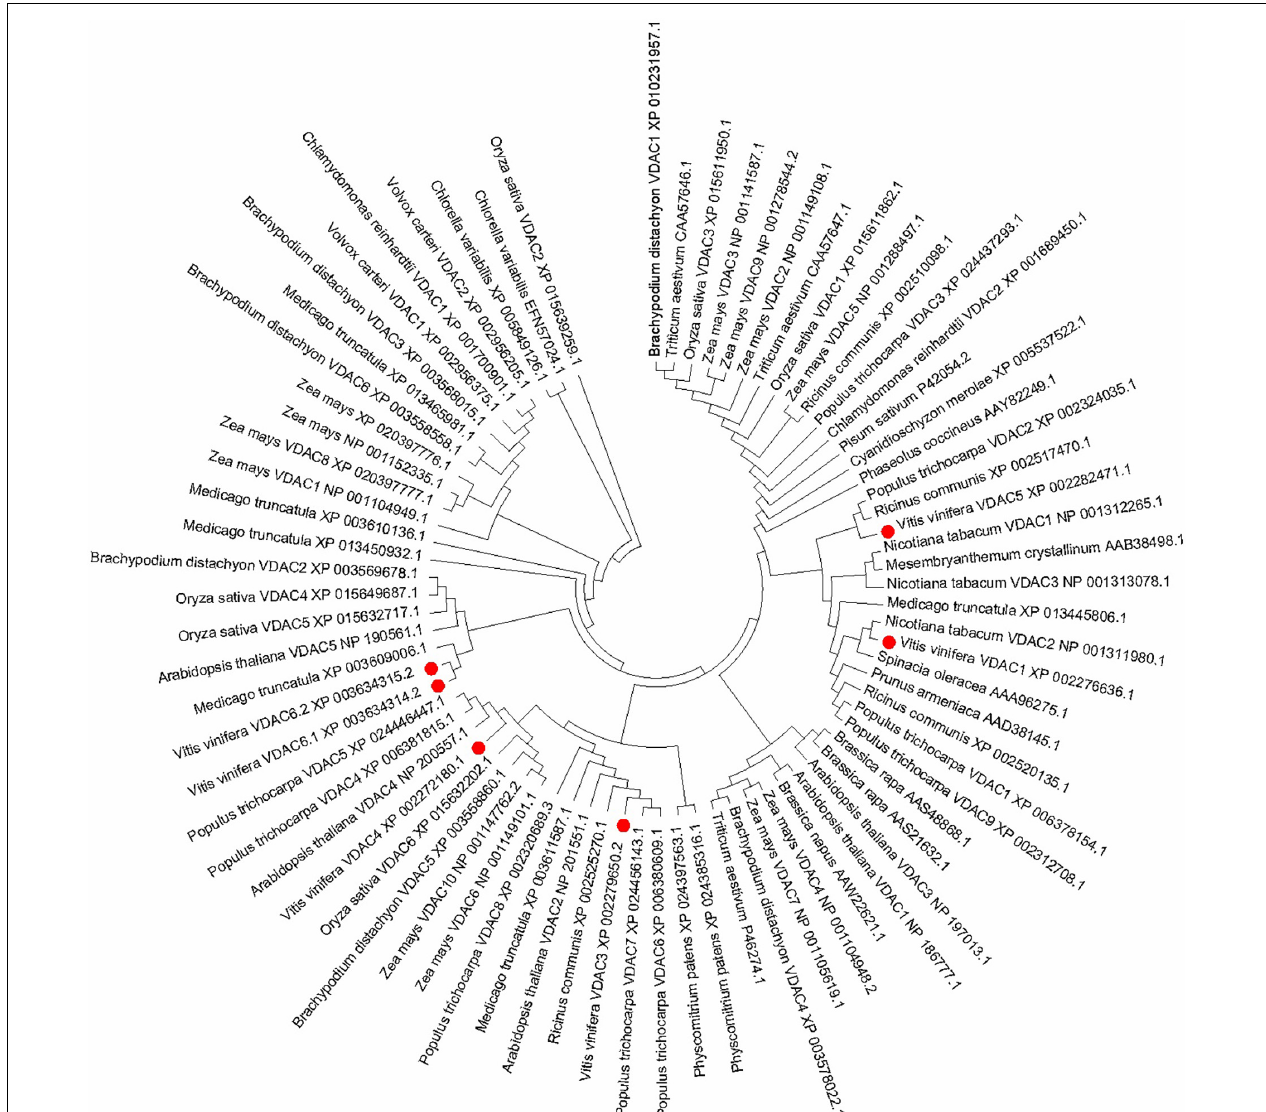
FIGURE 2 | Phylogenetic relationship tree of VDAC genes in plants. The phylogenetic tree was constructed in MEGA 7.0 using the maximum likelihood method (1000